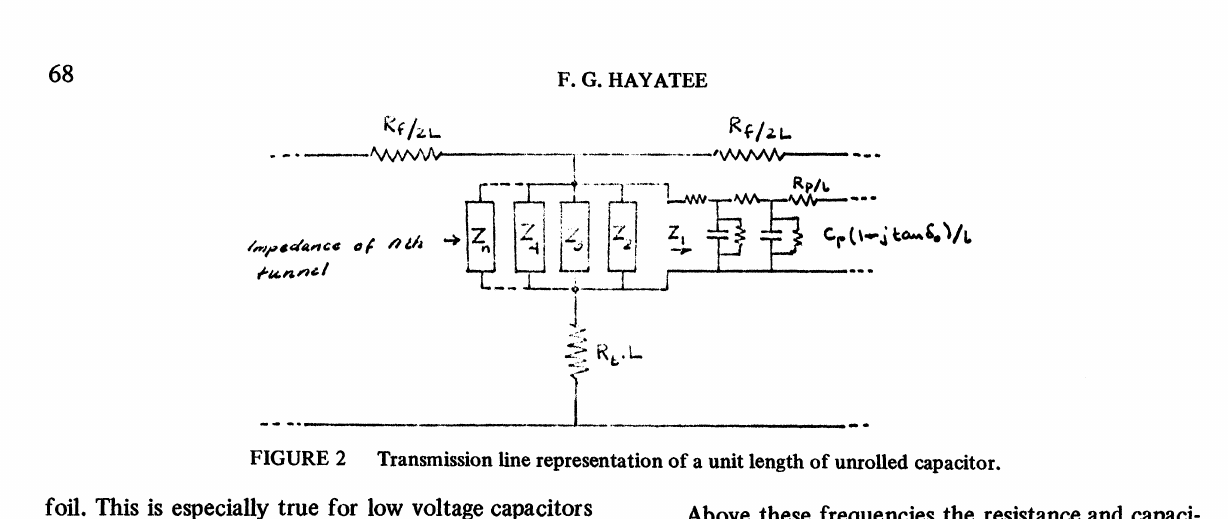
FIGURE 2 Transmission line representation of a unit length of unrolled